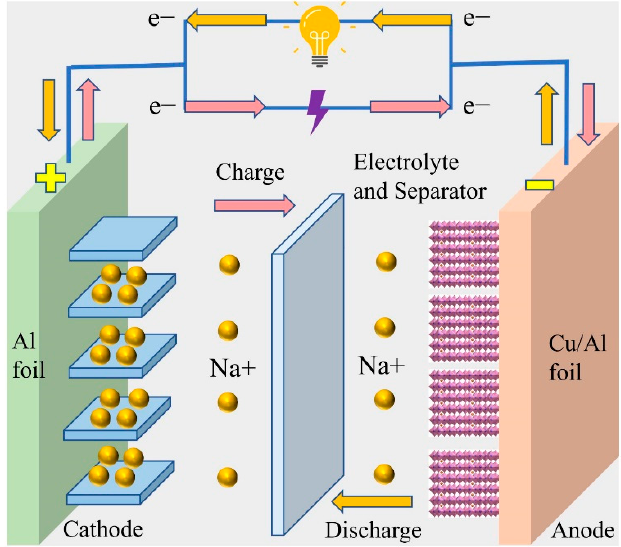
Figure 1. Schematic illustration of sodium storage mechanism for SIBs.